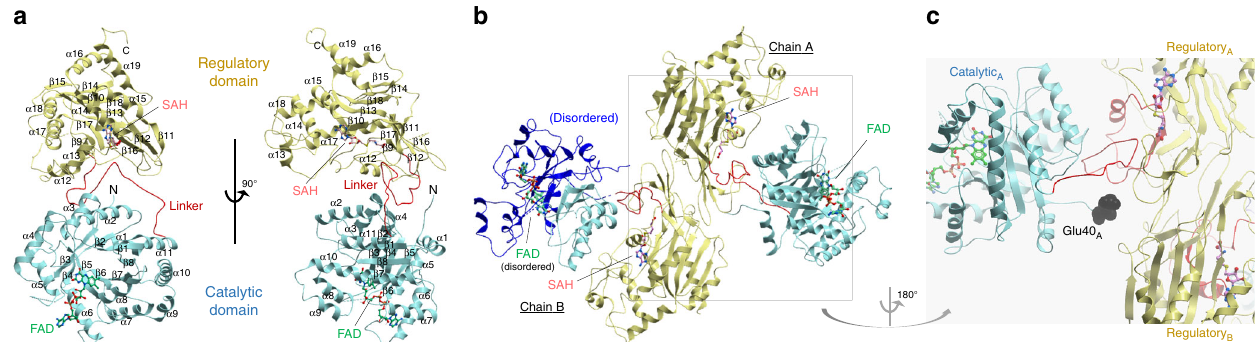
Fig. 4 Structural overview of Hs MTHFR. a Orthogonal views of Hs MTHFR showing the catalytic domain (cyan), the linker (red) and the regulatory domain (yellow). Bound FAD (green) and SAM (pink) are shown in sticks. Dotted lines indicate disordered regions that are not modelled in the structure. α -Helices and β -sheets are labelled, and correspond to the multiple sequence alignment in Supplementary Figs. 13 and 15 and the topology depicted in Supplementary Fig. 6. b Homodimer of Hs MTHFR as seen in the crystal. Chain A represents the more ordered protomer. In chain B, the part of the catalytic domain that was poorly ordered is represented in dark blue and only the main chain was modelled. The FAD in this subunit was also partially disordered. c Juxtaposition of the N-terminus of Hs MTHFR protomer towards both regulatory domains of the homodimer. The fi rst residue observed in the structure, Glu40 of chain A, is shown in black spheres. Other coloured features are as described for panel a